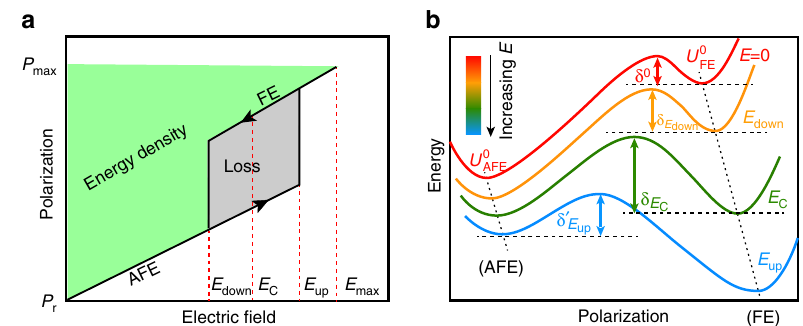
Figure 1 | Schematic illustrations. ( a ) The definition of stored energy density and energy loss from the typical polarization-versus-electric field double hysteresis loop of antiferroelectrics. The arrows indicate the charging and discharging processes. E up and E down denote the critical field at the AFE–FE and FE–AFE transitions, respectively. E C is the electric field at which the FE and AFE phases have precisely the same energy. ( b ) The energetic paths and barriers connecting the AFE and FE phases with increasing